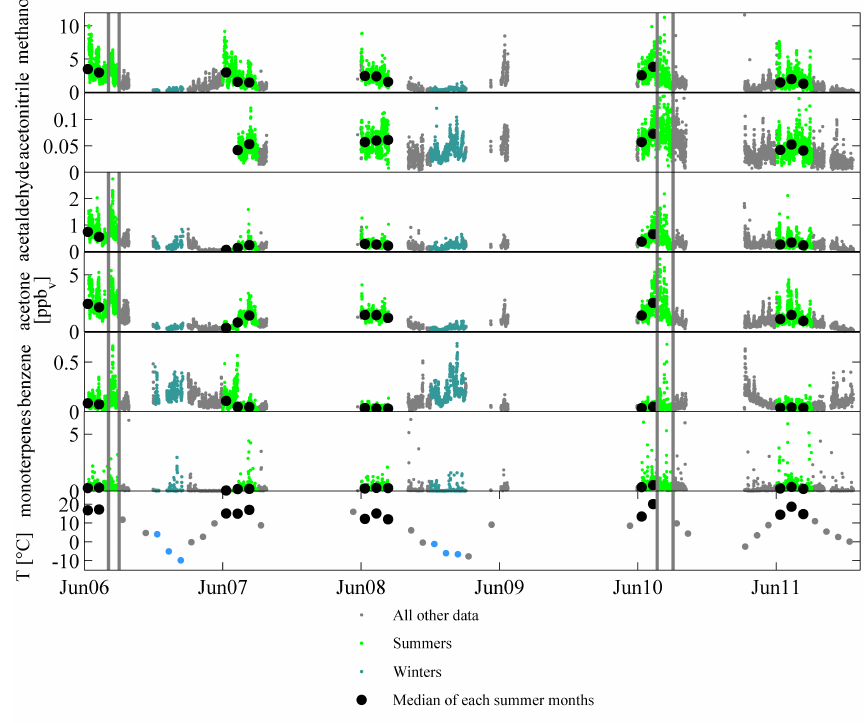
Figure 1. Time-series of the VMRs of the VOC studied during the measurement period. Summertime data used in source area analysis are marked in green and winter data in light blue. Data from other seasons are marked in grey. The monthly medians of the summer months are marked with black dots. The forest fire periods in the summers of 2006 and 2010 are marked with grey vertical